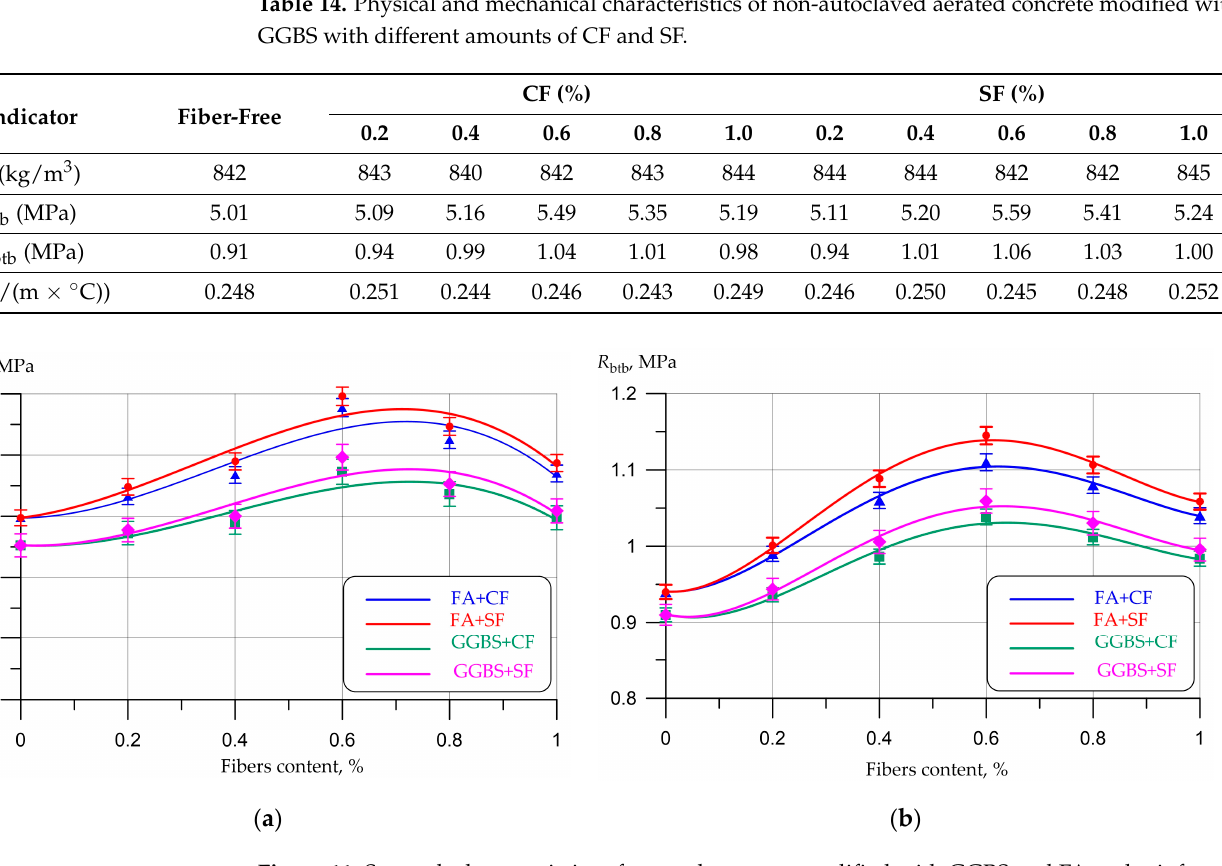
Figure 11. Strength characteristics of aerated concrete modified with GGBS and FA and reinforced with CF and SF: ( a ) compression strength; and ( b ) tensile strength in bending.